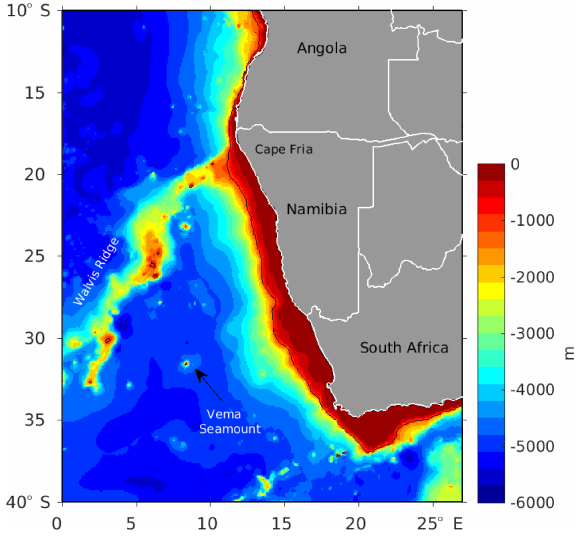
Figure 1. A map of the Benguela Current region showing local to- pography and